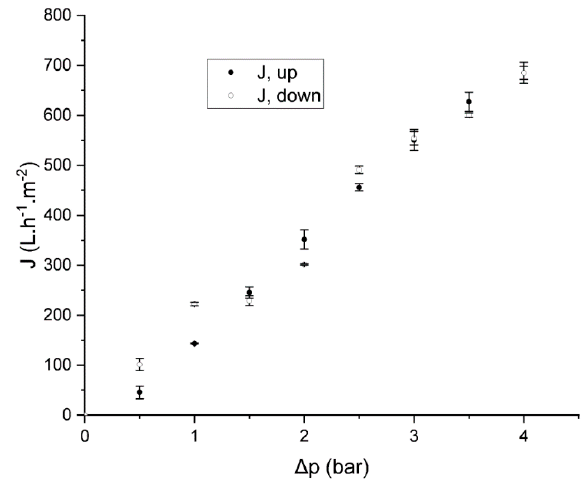
Figure 5. Water flux (J) as a function of the pressure drop when increasing (J, up) and decreasing (J, down) the water pressure of a membrane obtained from a micellar solution of 20 wt % of PMMA-b-PSBMA block copolymer solution in TFE:water mixture (87:13% in volume) casted on the surface of a commercial hydrophobic PVDF membrane using a 250 µm casting knife.